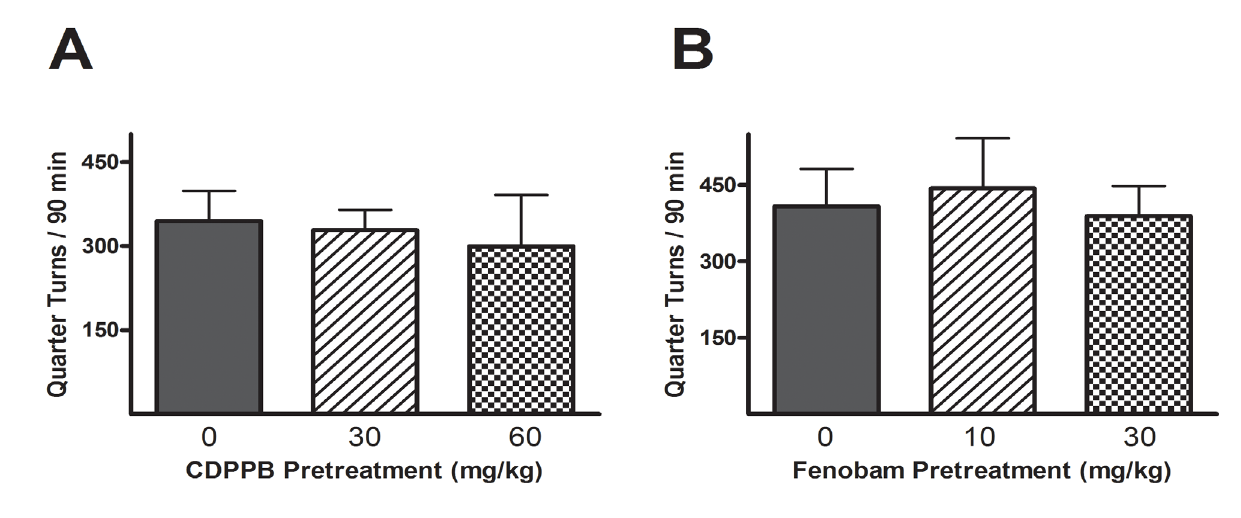
Figure 3. Effects of mGluR5 treatment on baseline locomotion in previously drug-naïve rats. CDPPB ( A ) or fenobam ( B ) was injected 30 min prior to locomotor testing. No significant effects were reported from the quarter turns collected over 90 min